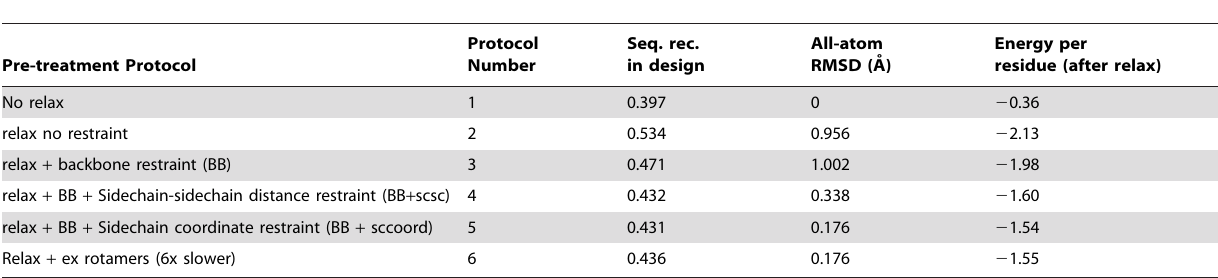
Table 1. RMSD after restrained relax with various restraint protocols and sequence recovery after Rosetta design.